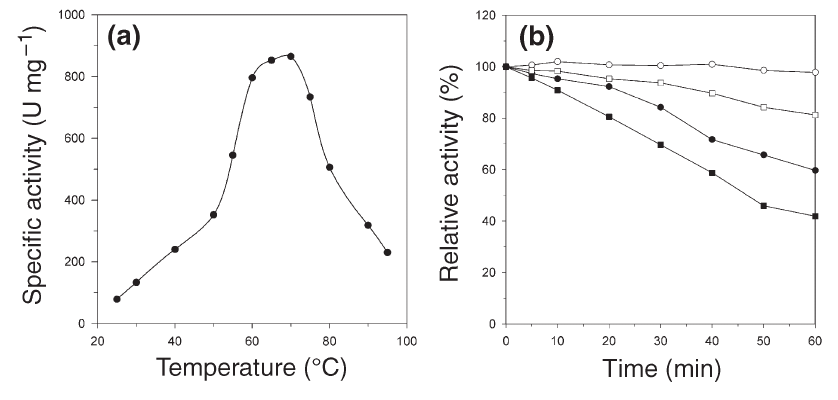
Figure 2. Thermophilicity and thermo- stability of Pyrococcus horikoshii pyrophosphatase ( Ph PPase). (a) The PPase activity was determined at the indicated temperatures, as described in the Materials and methods. Negative control reactions in the absence of the enzyme were performed in parallel. (b) Enzyme (1 µM Ph PPase in 50mM Tris-HCl, pH 7.5) was incubated at 100 °C in the presence ( (cid:2) ) or absence ( (cid:3) ) of Mg 2+ and at 105 °C in the pres- ence ( (cid:4) ) or absence ( (cid:5) ) of Mg 2+ , and the residual PPase activity of samples was measured at 60